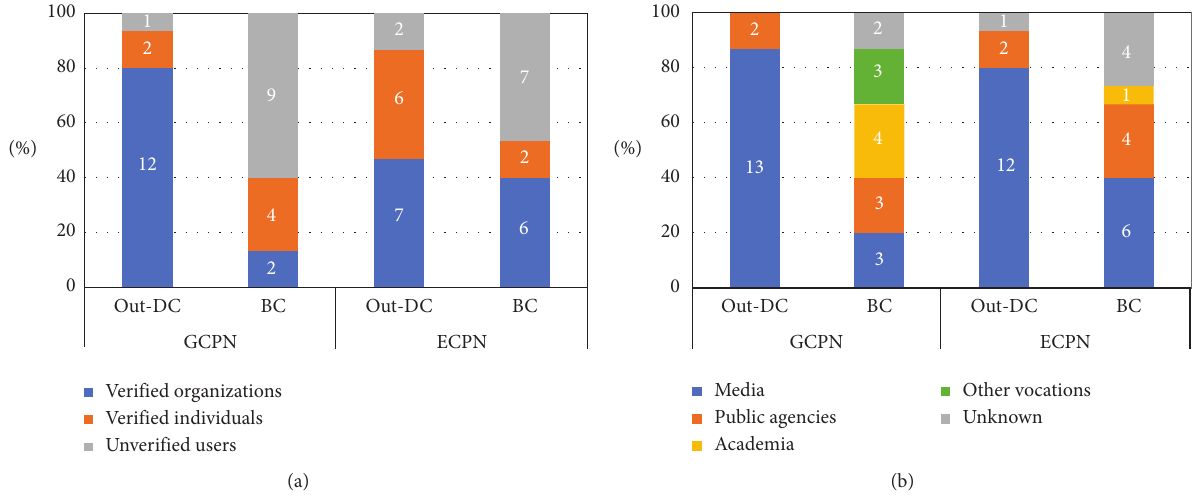
Figure 6: Fifty-top ranked participants aggregated by (a) verification identity and (b) occupational